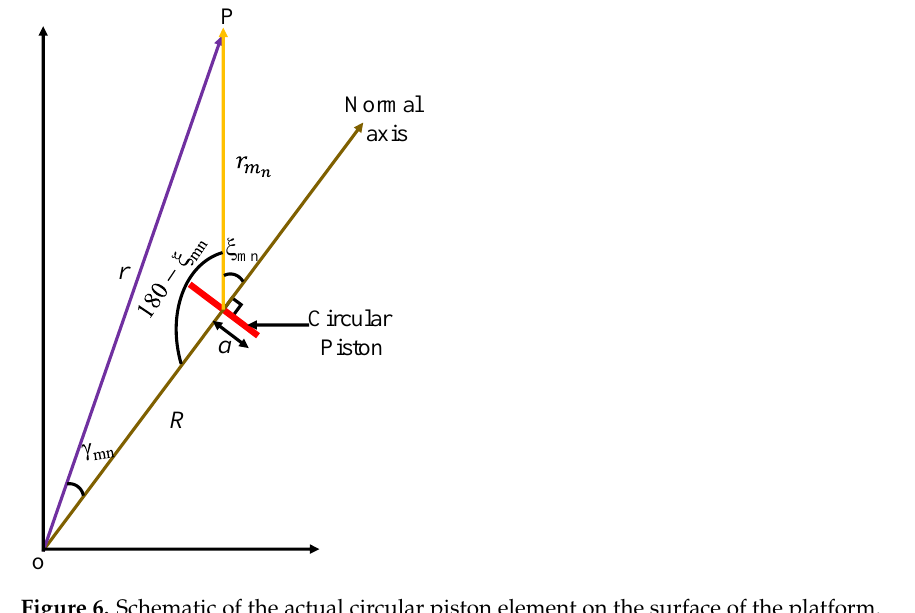
Figure 6. Schematic of the actual circular piston element on the surface of the platform.